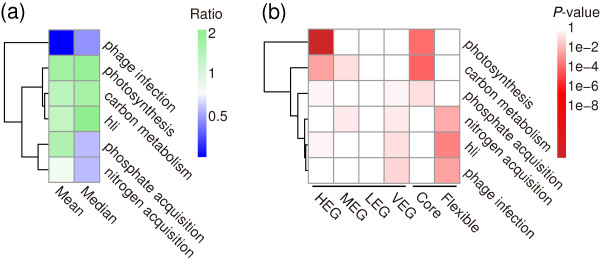
Varied expression in six cellular processes, including photosynthesis[45], carbon metabolism[46], phosphate acquisition[47], nitrogen acquisition[46], hli (high-light inducible genes), and phage infection[48]. (a) Expression profiles of six cellular processes. For each gene, the mean expression in ten samples was used as its expression value. For six functional categories, the mean and median expression values were normalized to values of ribosomal genes. (b) Enrichment analysis of four expression subclasses (HEG, MEG, LEG, and VEG) for six functional processes (Fisher’s exact test, one-tailed). Core: the core genome; Flexible: the flexible genome, HEG: highly expressed genes; MEG, moderately expressed genes; LEG, lowly expressed genes; VEG, variably expressed genes.